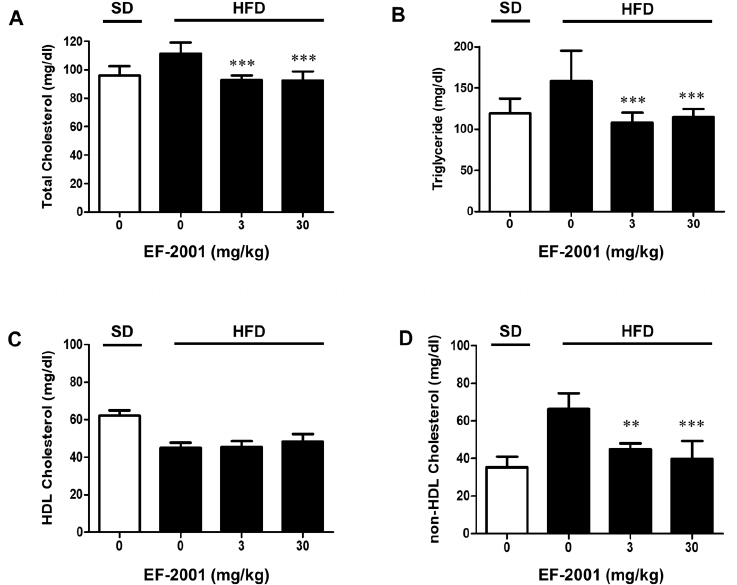
Figure 2. Effects of EF-2001 on the levels of total cholesterol, TG, HDL, and non-HDL in serum of high fat diet-induced obese rats. After six weeks of feeding, rats were fasted for 12 h, and then blood was collected. The effects of EF-2001 on the contents of total cholesterol ( A ), triglycerides ( B ), HDL ( C ), and non-HDL levels ( D ) in HFD-induced serum were measured. Data are represented as the mean ± SEM. ( n = 6); ** p < 0.01, *** p < 0.001 vs. control (without EF-2001 in HFD-induced obese rats). 3.3. EF-2001 Inhibits Lipid Accumulation in Differentiated 3T3-L1 Adipocytes Inhibition effect of EF-2001 on lipid accumulation is presented as ORO-stained 3T3- L1 adipocytes. Data are shown in Figure 3A. Treatment with EF-2001 decreased the level of ORO staining in a dose-dependent manner. Additionally, EF-2001 inhibited the accu- mulation of intracellular lipids. DM with 100 or 250 μ g/mL of EF-2001 resulted in 15 and 30% reduction in lipid accumulation compared with the untreated control (Figure 3B).